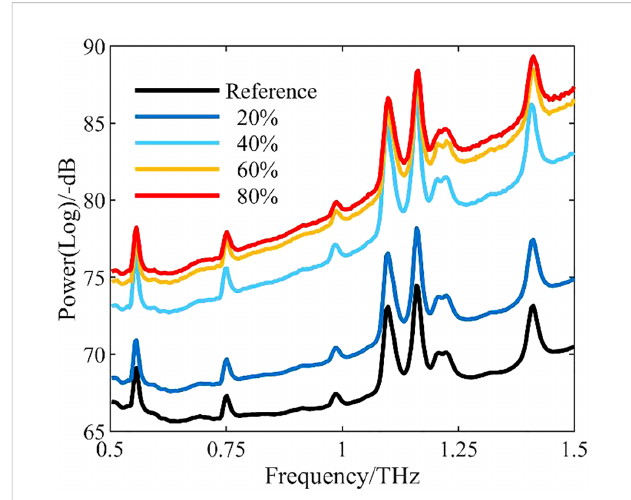
FIGURE 2 Curves of mean power measured for different water levels. Reference is the background data collected when no leaf samples were present.